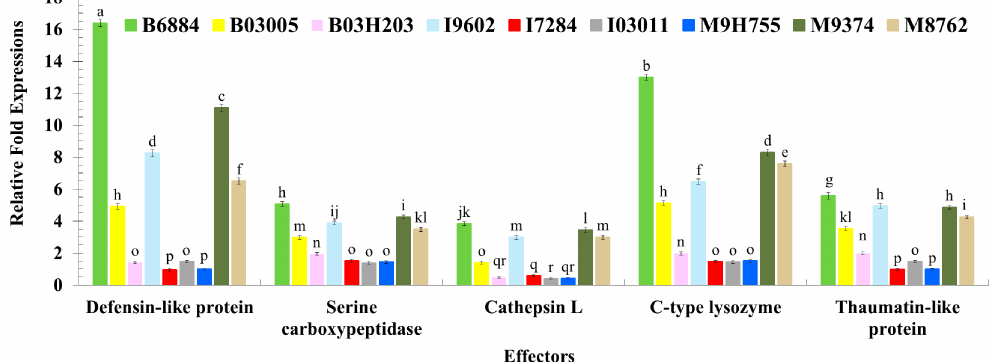
Figure 5. Relative fold-expression of effectors of Rhynchophorus ferrugineus larvae in response to fungal infections using quantitative real-time PCR. Means ± SE values followed by different letter(s) are significantly different. (Fisher’s Least Significant Difference (LSD) test, α = 0.05).